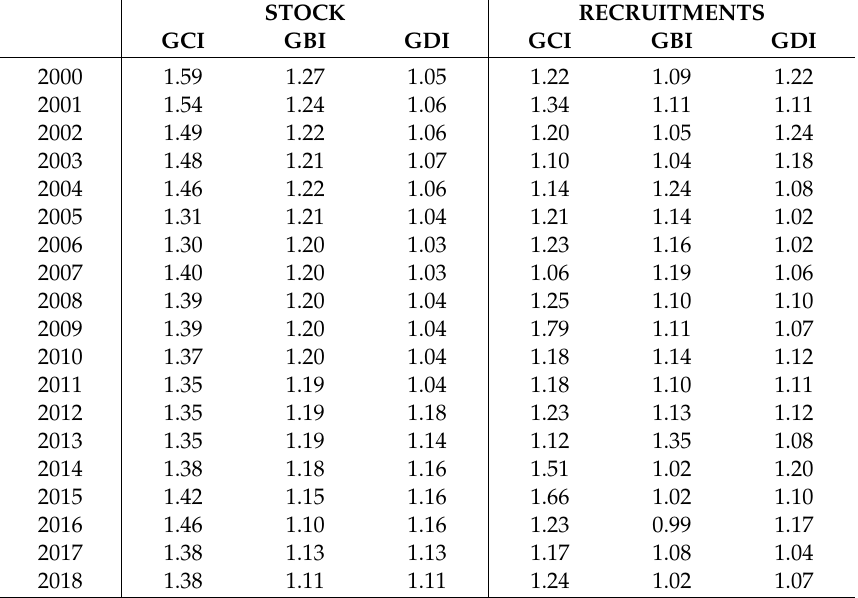
Table 3. Glass Ceiling Index (GCI), Glass Bottleneck Index (GBI), and Glass Door Index (GDI). STOCK RECRUITMENTS